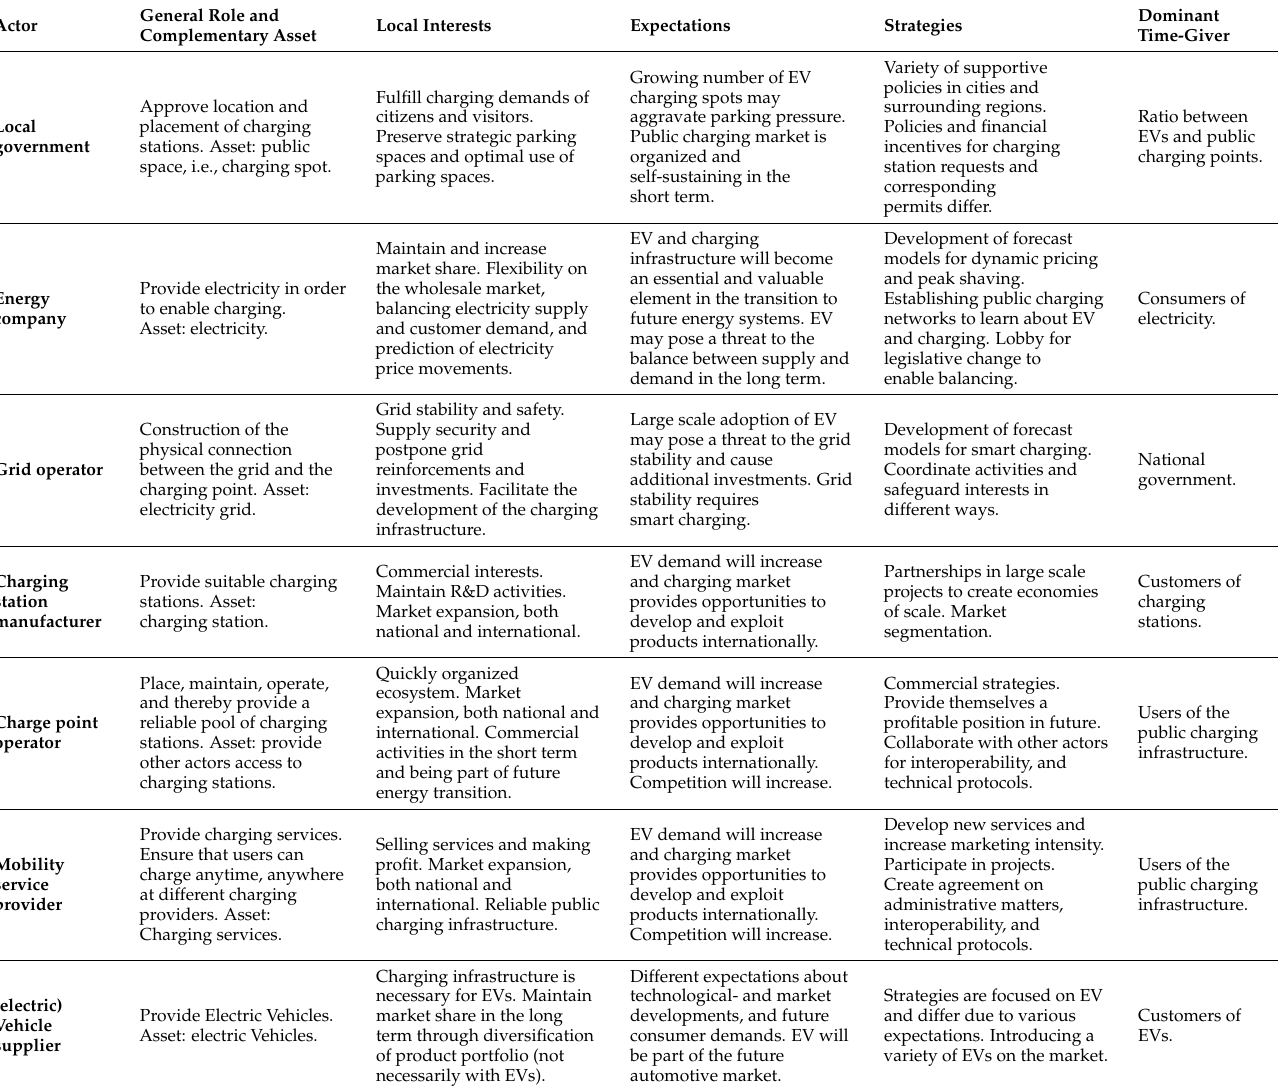
Table 1. Overview of the public charging ecosystem’s